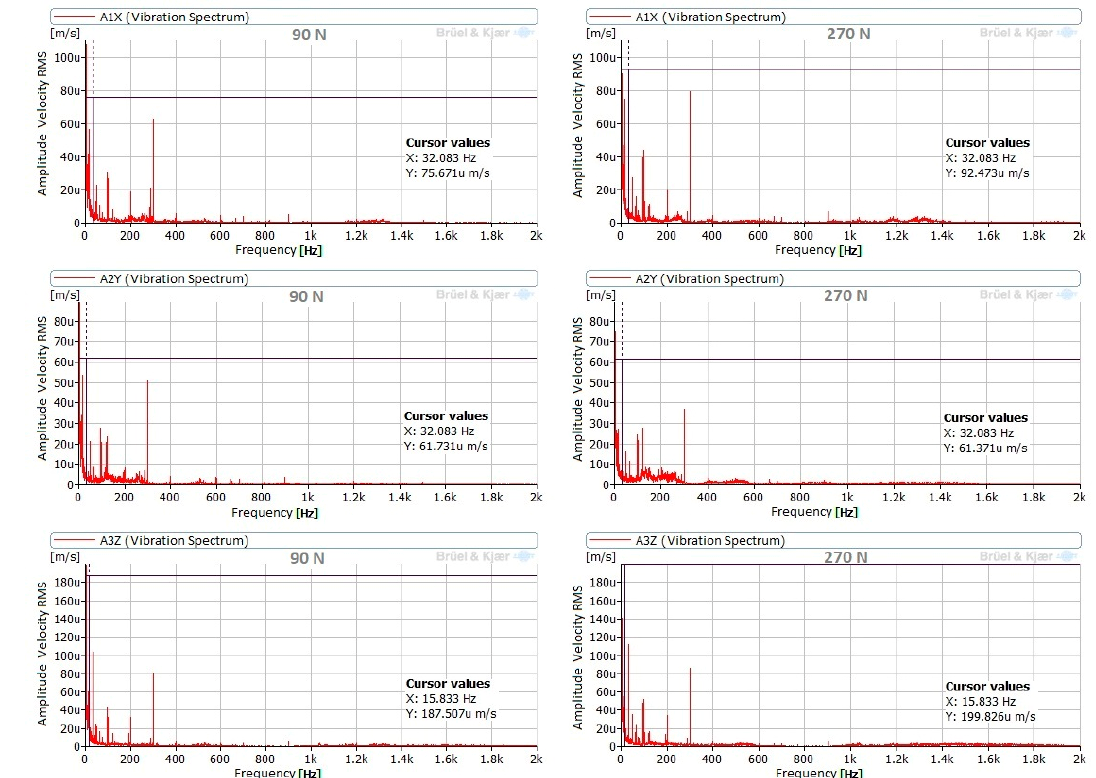
Figure 10. Comparison of spectra of C45 with burnishing forces of 90 N and 270 N, without vibration assistance.